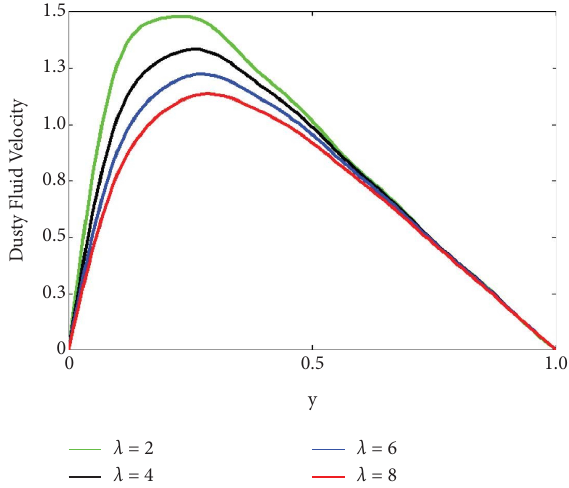
Figure 7: Te impact of diferent values of λ on ψ